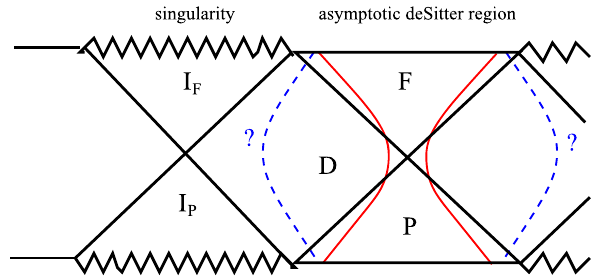
Fig. 1 Timelike extremal surfaces w(τ) in SdS stretching between I ± , shown as the red curves passing through the vicinity of the cosmolog- ical horizon. The dashed blue curves represent hypothetical timelike extremal surfaces of similar nature, but passing near the Schwarzschild horizon in some